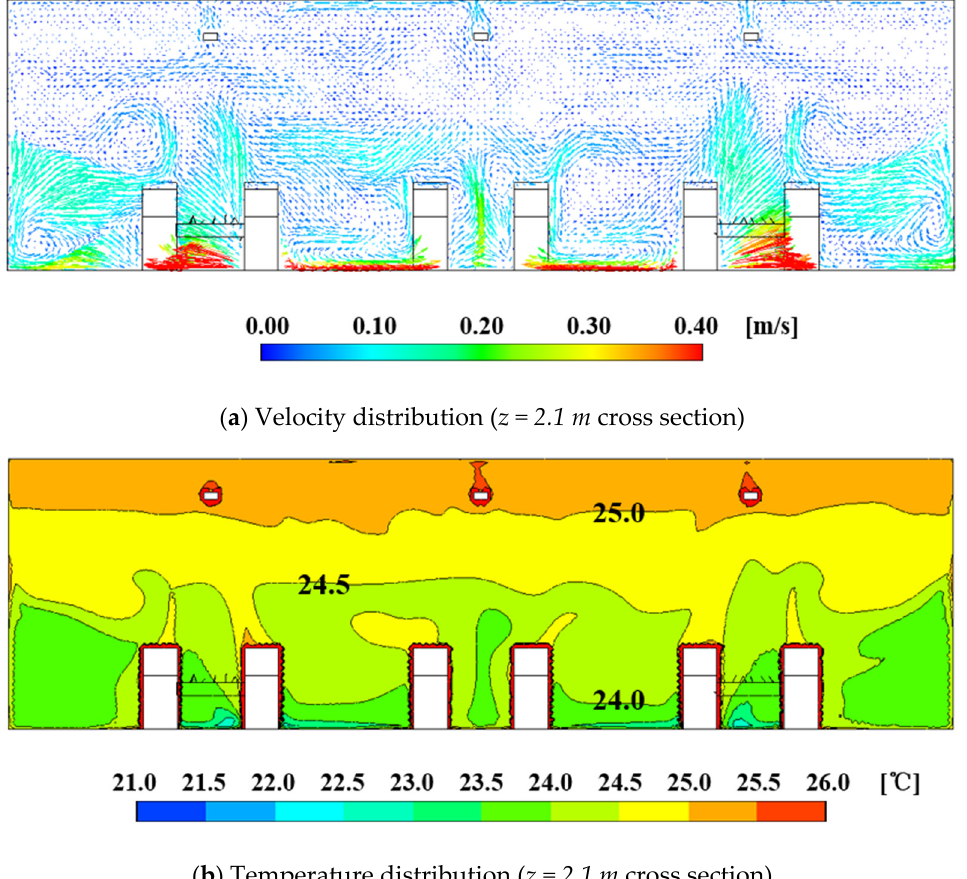
Figure 6. Velocity and temperature distributions ( z = 2.1 m cross section).